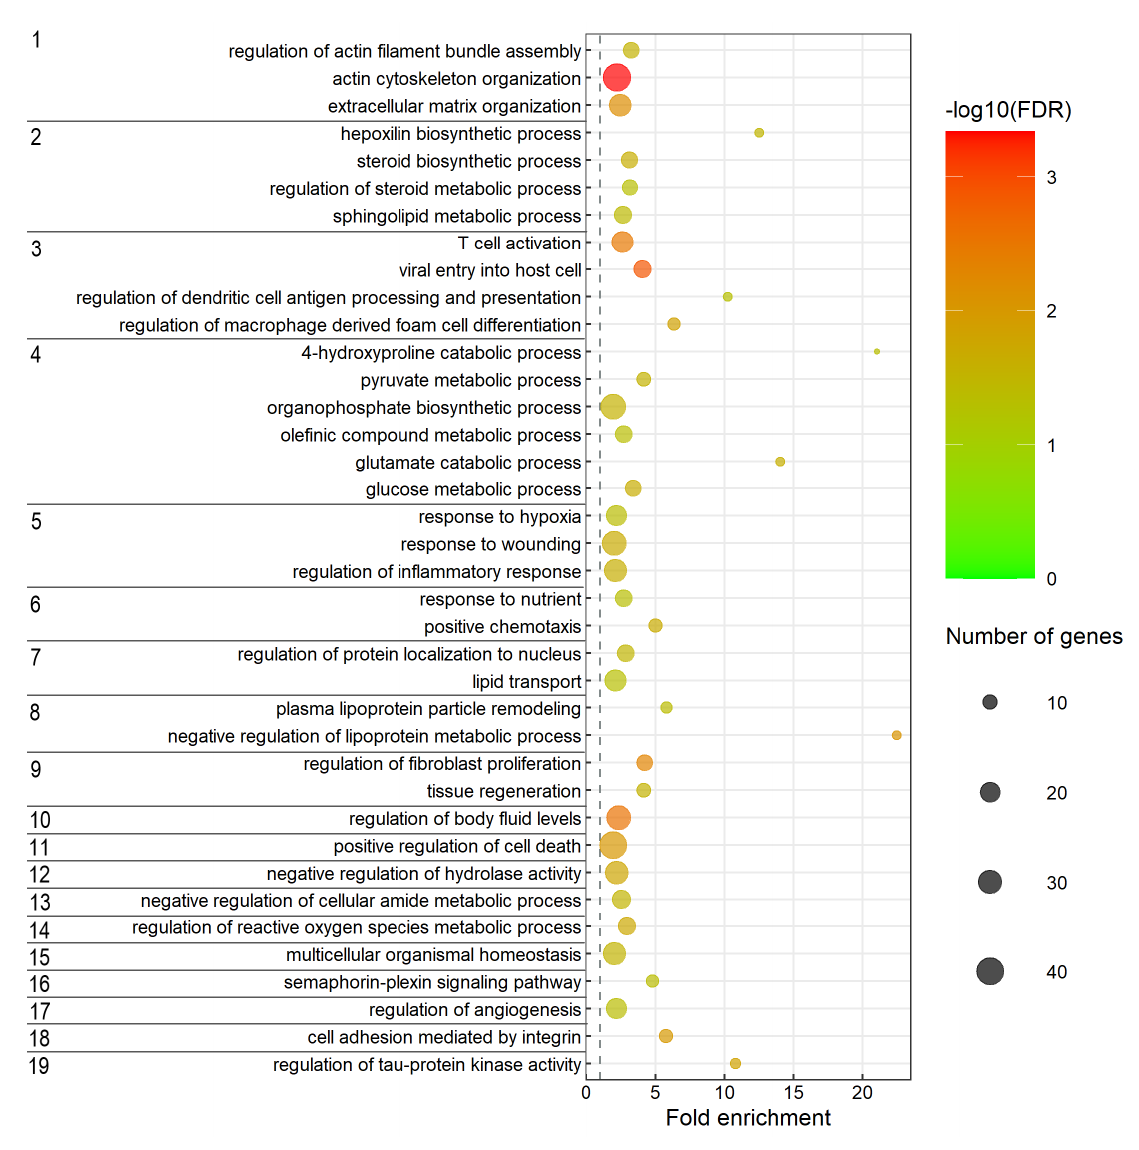
Figure 4. Biological processes significantly enriched in the predicted target genes of the gDE-miRNA dataset. The specific and representative subclasses of biological processes are shown on the y-axis. 2. Lipid metabolic process, 3. Immune system, 4. Organic substance metabolic process, 5. Response to stress, 6. Response to chemical, 7. Transport, 8. Protein metabolic process, 9. Regulation of cell growth, 10. Regulation of body fluid levels, 11. Regulation of cell death, 12. Regulation of molecular function, 13. Cellular nitrogen compound metabolic process, 14. Reactive oxygen species metabolic process, 15. Homeostatic process, 16. Signal transduction, 17. Angiogenesis, 18. Cell adhesion and 19.